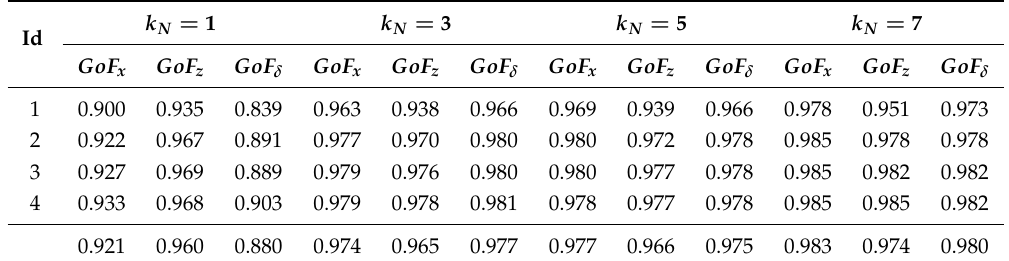
Table 4. GoF results of the NN model for each tuning wave for different delay steps k N . The number of neurons are fixed to 10. The last row stores the mean values.